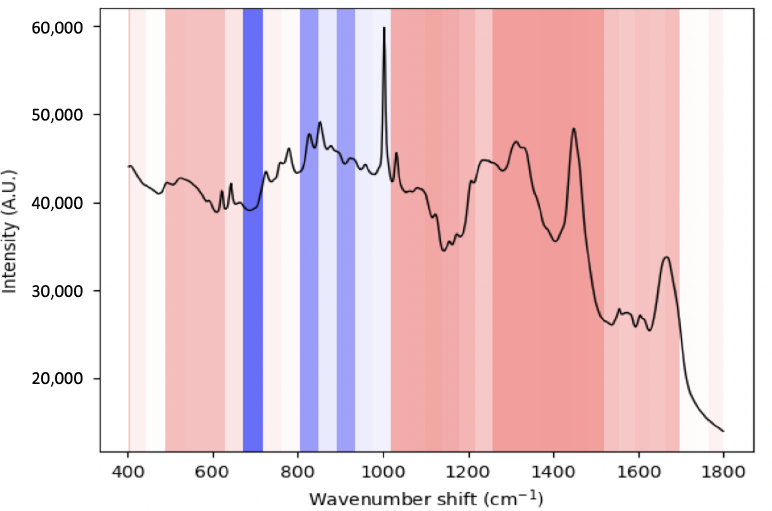
Figure 5. Occlusion study: Blue indicates drops in performance due to occlusion. The stronger the shade, the larger the drop in